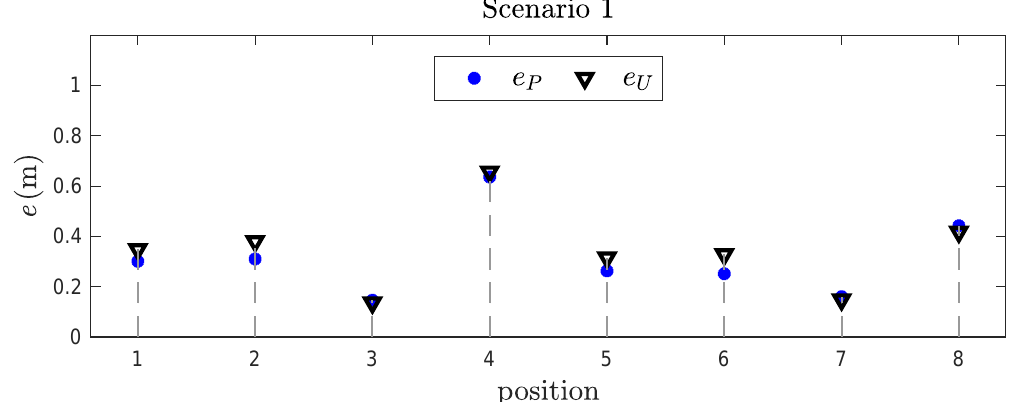
Figure 2. The average errors in Scenario 1 for the PSO algorithm ( e P ) and for the POST U algorithm ( e U ) shown in